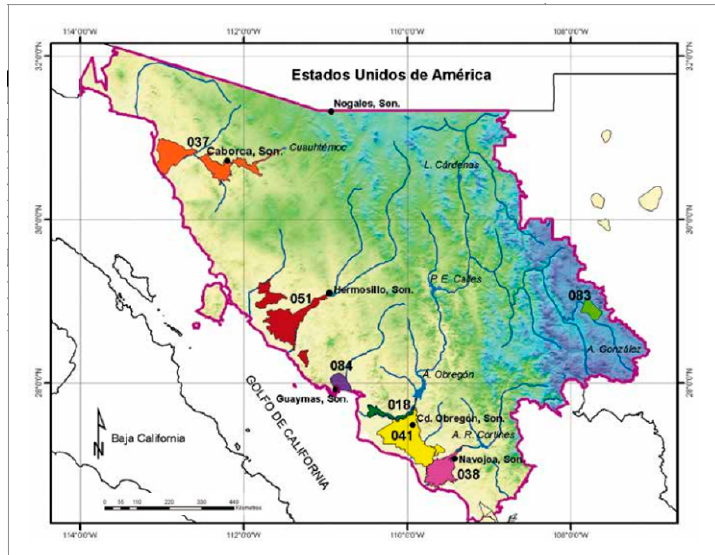
Figure 1. Location of irrigation districts of the basin organisation: Northwestern Mexico. District 051 Costa de Hermosillo, Sonora, Mexico [34]. Sonora borders the American states of Arizona and New Mexico.